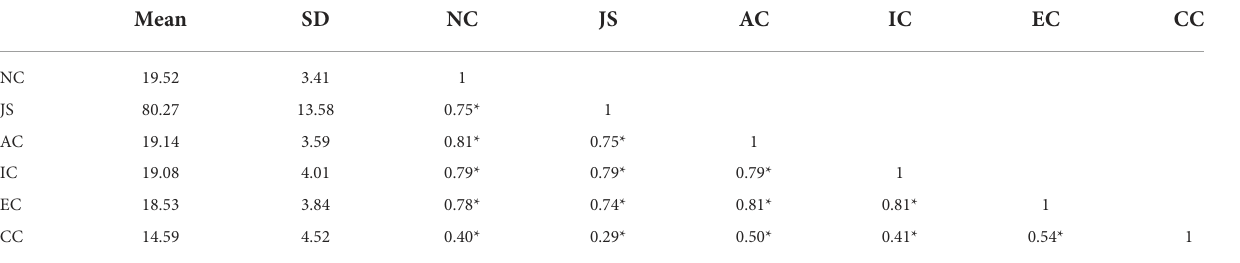
TABLE 2 Correlation between job satisfaction and five dimensions of organizational